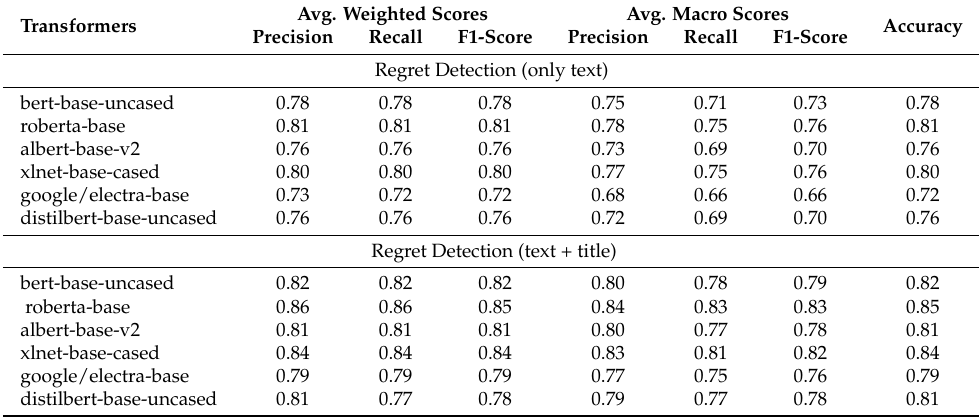
Table 4. Results regarding regret detection using transformers.